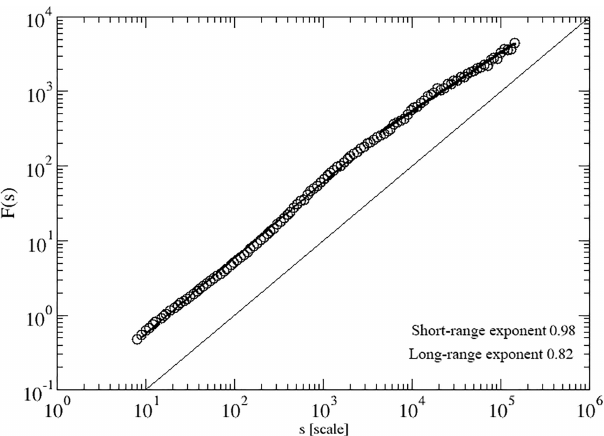
Figure 8. Five samples of SPL data (real, black; modelled, red). (a) Samples of data; (b) DFA scaling curves. The thin line in the panels of the right column denotes the slope with scaling expo- nent 1, to which the curves are very close. The modelled data have the same probability density and scaling properties as the real